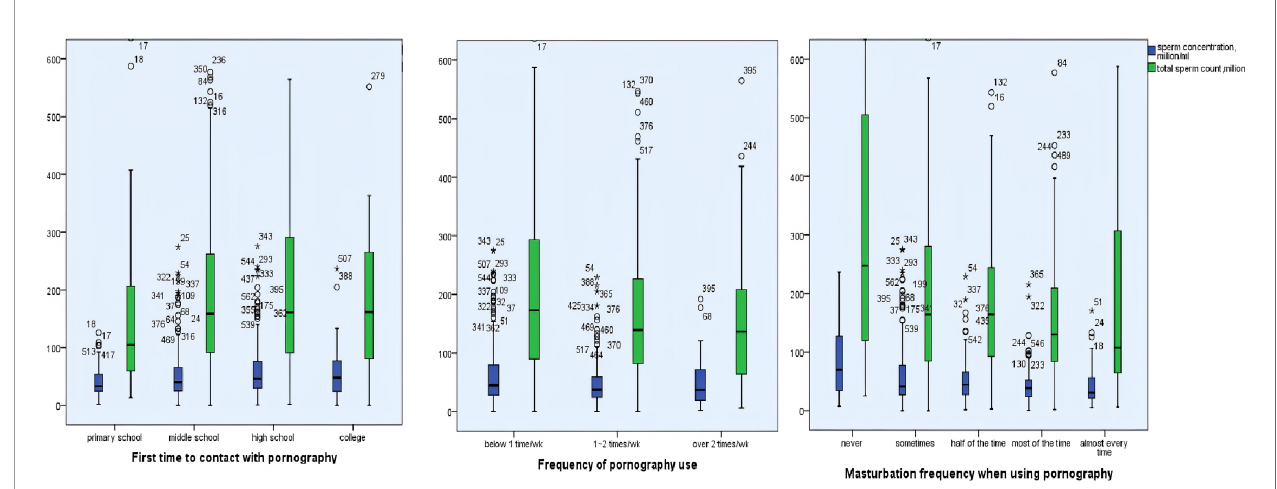
FIGURE 2 | Univariate analyses were applied to estimate the associations between pornography use and semen parameters. The ages of fi rst-time contact pornography were positively correlated with sperm concentration and total sperm count ( p < 0.05). The frequency of pornography use and masturbation frequency when using pornography were negatively correlated with sperm concentration and total sperm count ( p < 0.05, p < 0.05). *:extreme values.